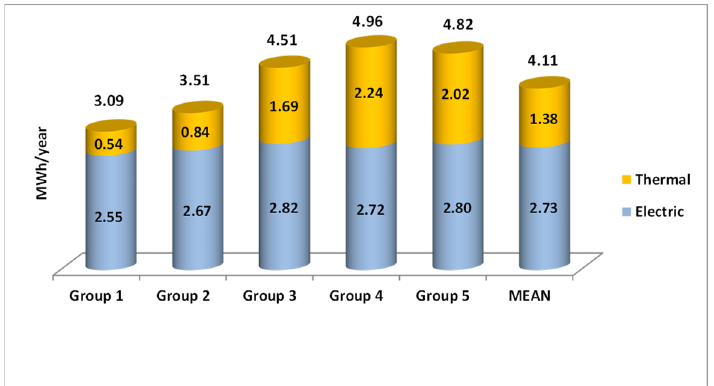
Figure 5. Thermal, electric, and total mean energy consumption per inhabitant by group.